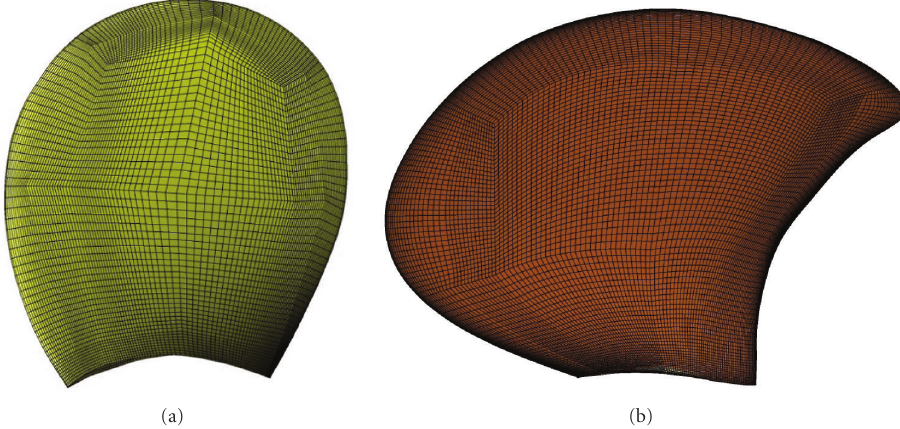
Figure 10: Suction side surface meshes, E779A propeller (a), PPTC propeller (b).